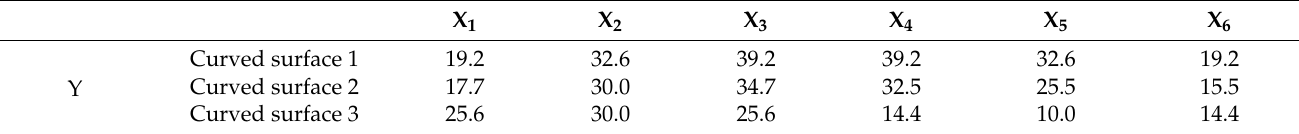
Table 1. Moving values of rods by curve.